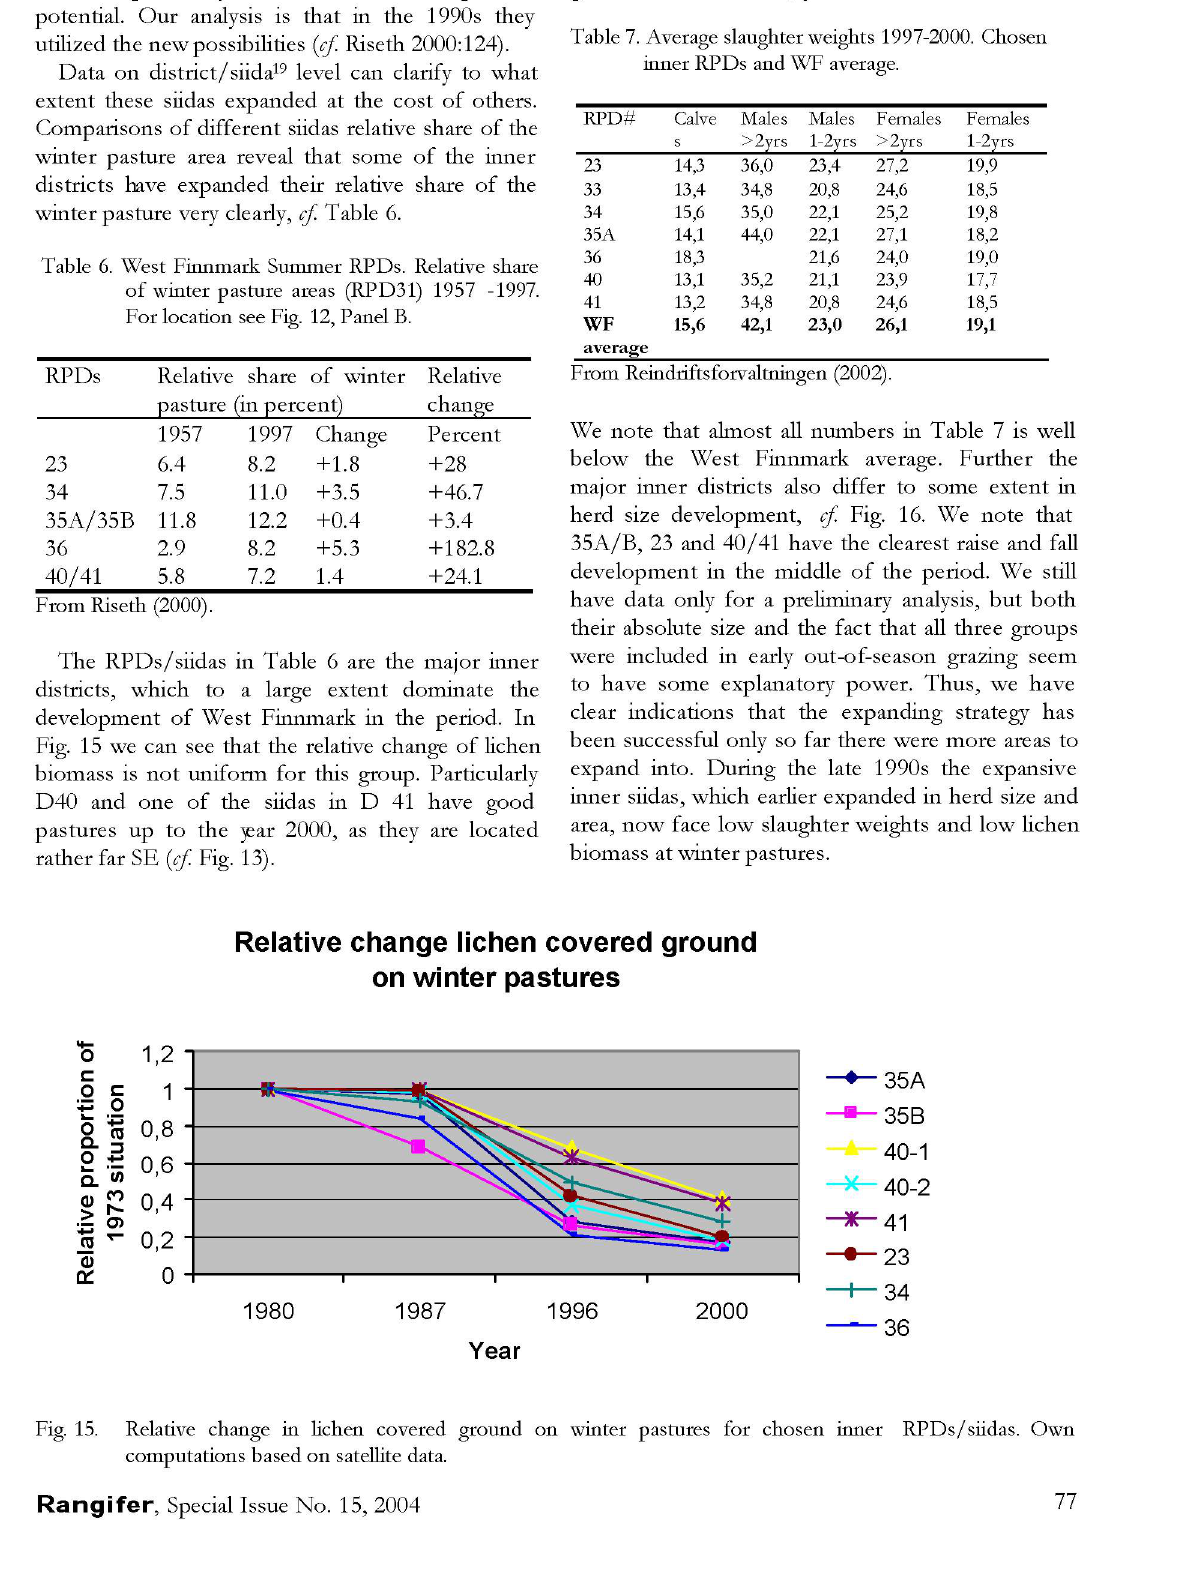
Relative change in lichen covered ground on winter pastures for chosen inner RPDs/siidas. Own computations based on satellite